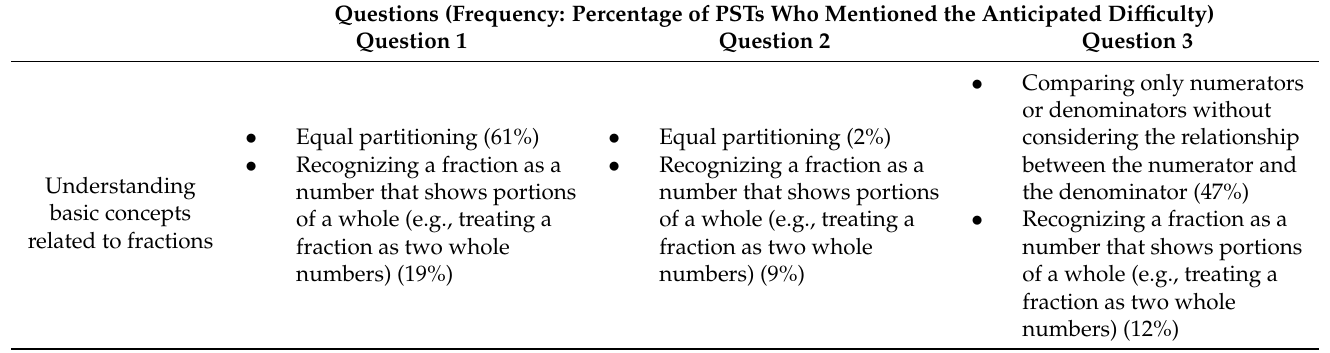
Table 2. Student difficulties to address in assessment (as reported by